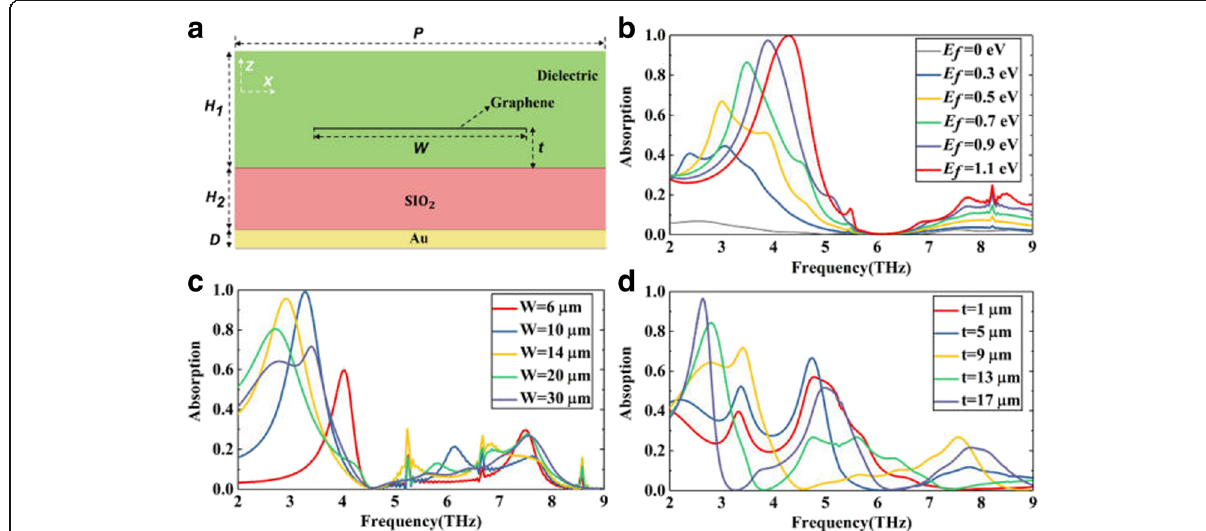
Fig. 3 a Schematic diagram of a single-layer graphene structure. b – d The absorption of the structure width different Fermi energy E f , width W , and position t of the graphene sheet, respectively